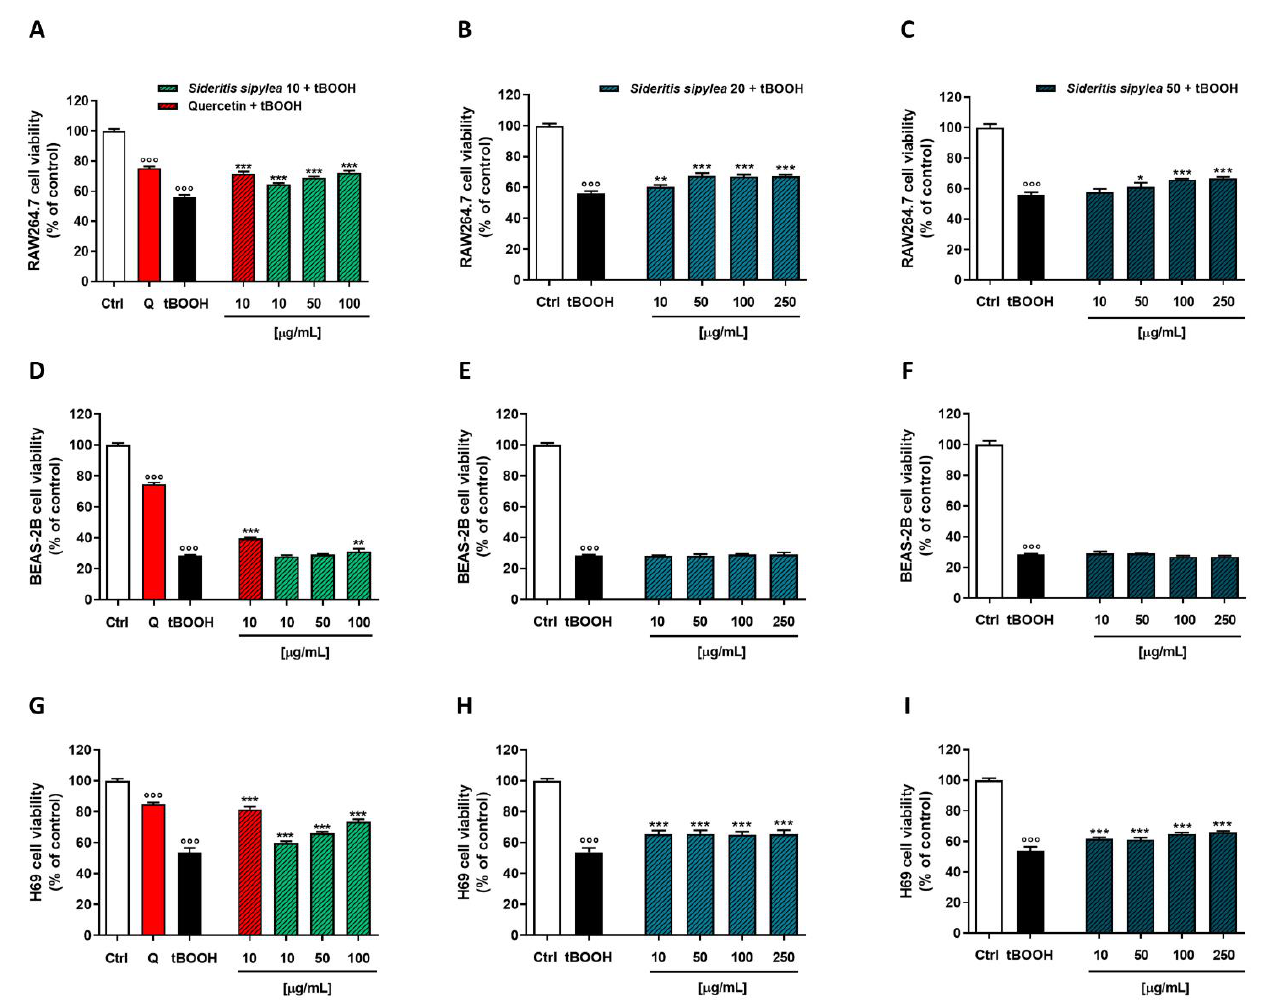
Figure 6. Cytoprotective activity of the positive control quercetin (Q) and S10, S20, and S50 fractions from Sideritis sipylea Boiss towards the tBOOH-induced oxidative damage in nonmalignant mouse macrophages RAW264.7 ( A – C ), human bronchial epithelium BEAS-2B cells ( D – F ), and human intrahepatic cholangiocytes H69 ( G – I ) determined by Neutral Red assay. Data displayed as mean ± SE of at least three technical replicates from two experiments ( n = 3). °°° p < 0.001 vs. control (Student’s t -test); * p < 0.05, ** p < 0.01, and *** p < 0.001 vs. tBOOH (one-way ANOVA followed by Dunnett’s multiple comparison post -test).